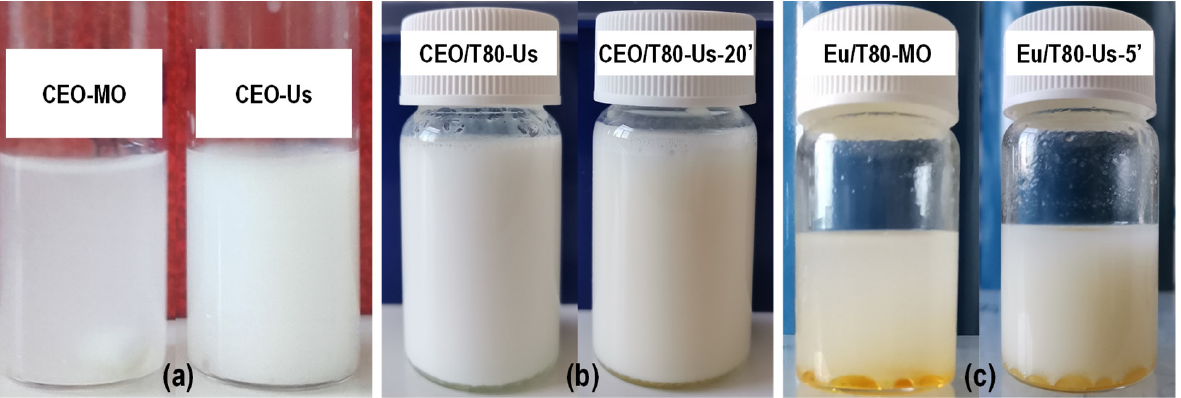
Figure 2. The visual aspect of ( a ) clove essential oil (CEO) dispersions in acetic acid solutions obtained without emulsifier by mechanical homogenization (CEO-MO) or ultrasonication (CEO-US); ( b ) CEO